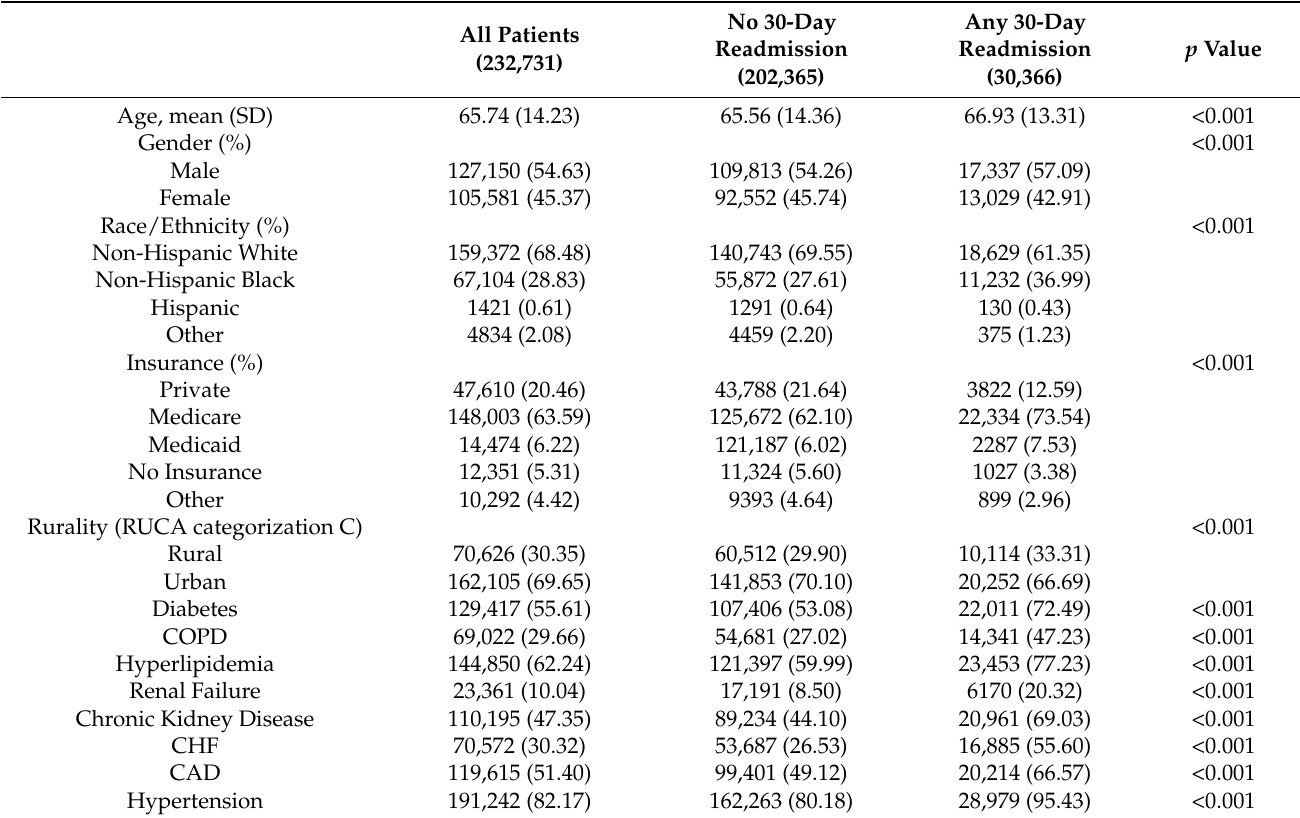
Table 1. Patient-level characteristics of all-cause hospital 30-day